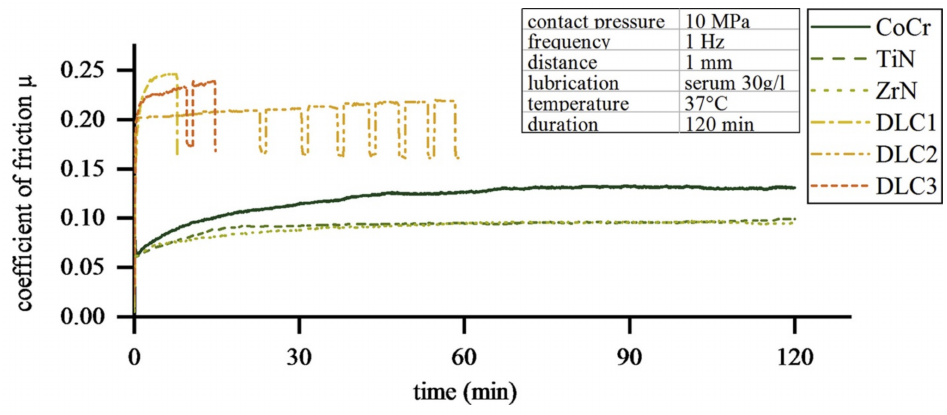
Figure 10. Friction results for different coated materials. Reprinted with permission from